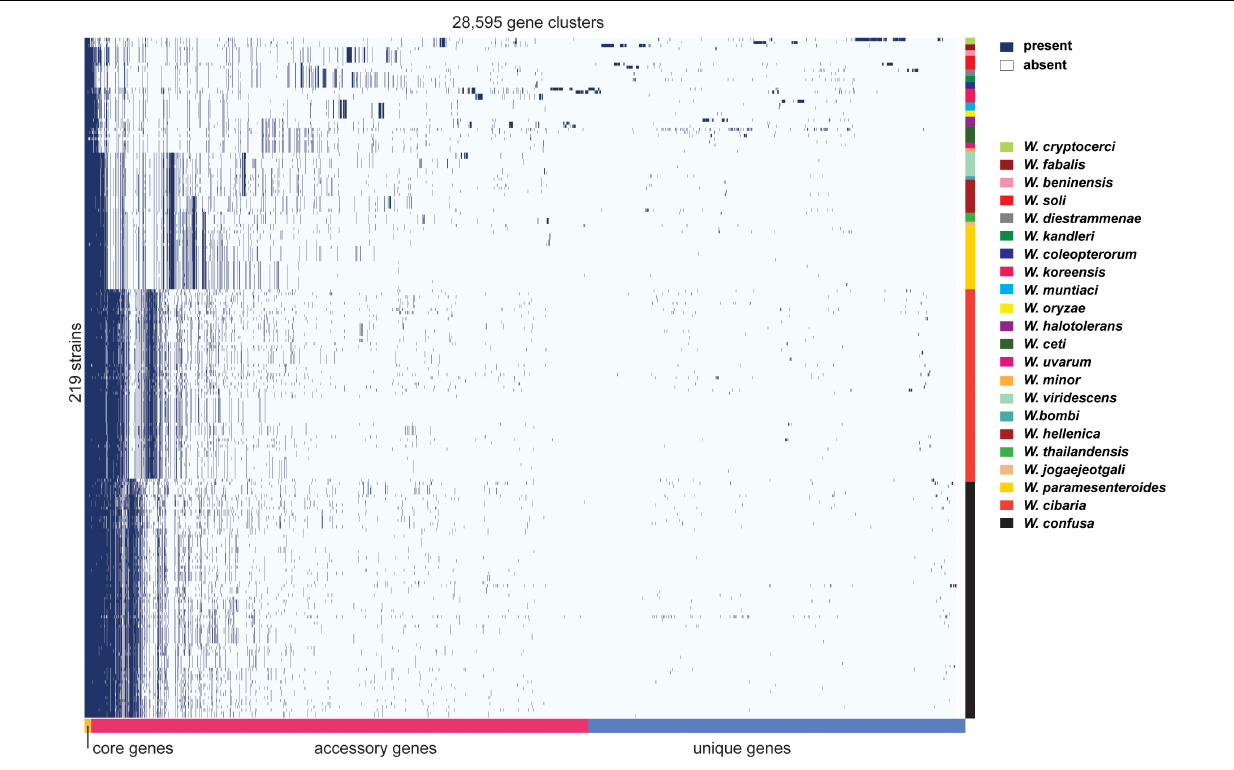
FIGURE 5 | Pan-genome matrix of 219 Weissella genomes from 22 species. The right-hand color bars indicate the species boundary in the matrix. Lime, cherry, rose, red, gray, emerald, dark blue, pink, blue, yellow, violet, basil, magenta, cream, mint, teal, apple, green, wood, gold, orange, and black colors (from top to bottom) represent W. cryptocerci , W. fabalis , W. beninensis , W. soli , W. diestrammenae , W. kandleri , W. coleopterorum , W. koreensis , W. muntiaci , W. oryzae , W. halotolerans , W. ceti , W. uvarum , W. minor , W. viridescens , W. bombi , W. hellenica , W. thailandensis , W. jogaejeotgali , W. paramesenteroides , W. cibaria , and W. confusa ,